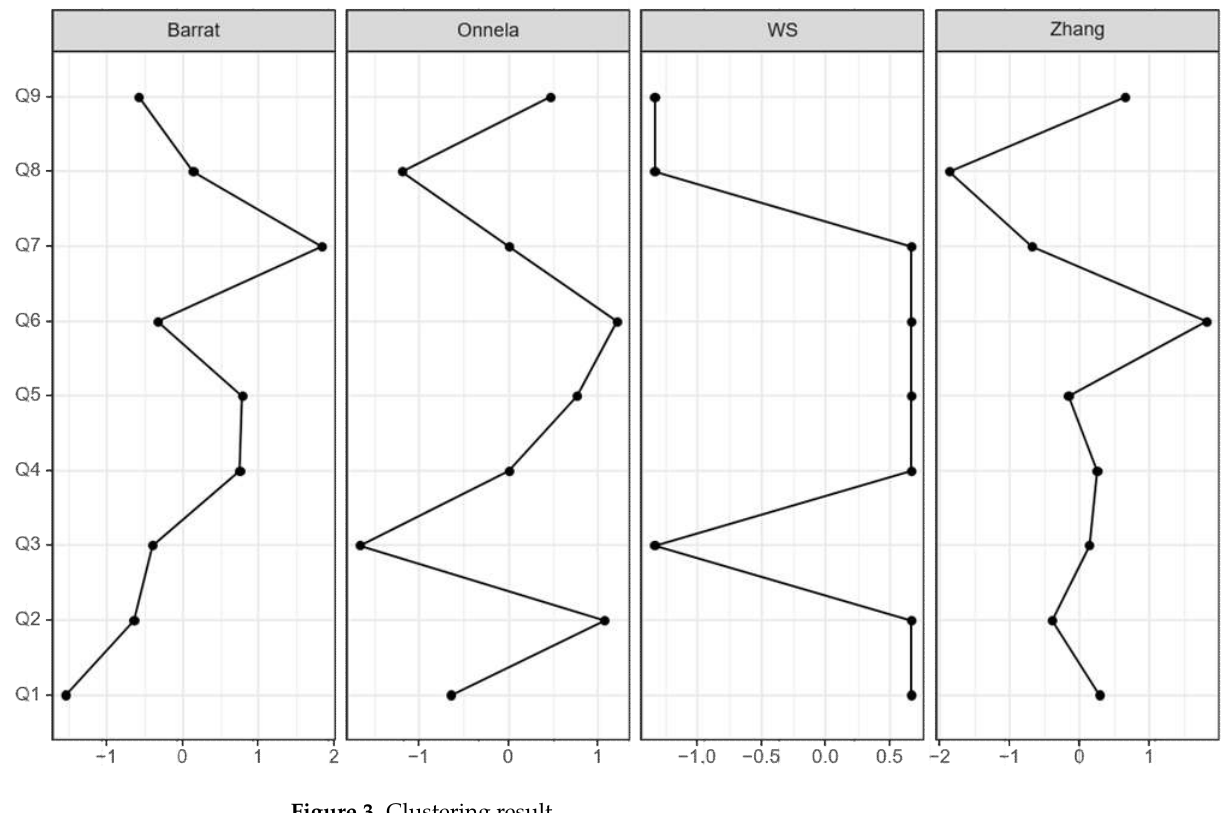
Figure 3. Clustering result. Table 3. Clustering measures per variable in SMC. Table 3. Clustering measures per variable in